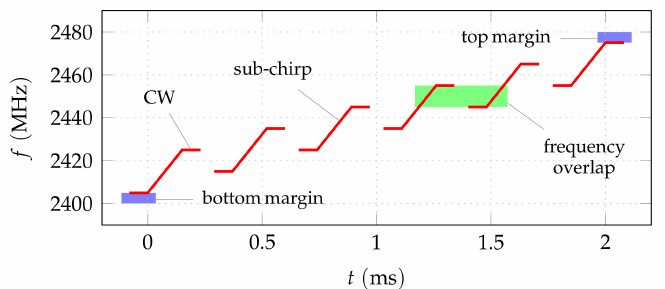
Figure 1. Basic characteristics of the proposed modulation format in the time-frequency plane. Customized chirped waveform generation allows to cover a bandwidth much larger than the typical transmission bandwidth of about 1MHz. The typical transmitter hardware characteristics limit the achievable chirp-width to about 10MHz to 12MHz. By using overlapping sub-chirps, an even larger bandwidth can be covered coherently if the phase relations between the sub-chirps are recovered. Leading and trailing continuous wave (CW) periods allow for the required frequency synchronization between transmitter and receiver. Due to hardware limitations, band margins are required which limits the usable bandwidth within the available frequency